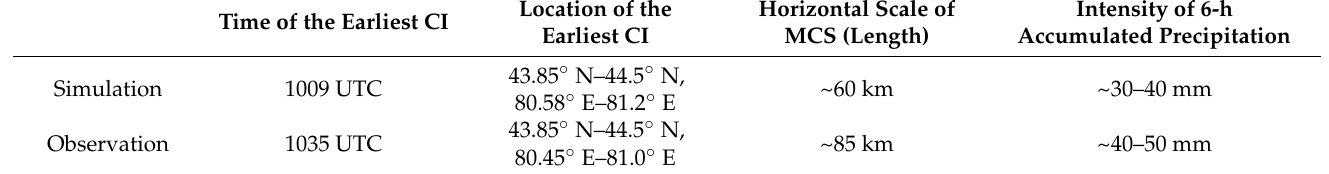
Table 1. The basic features of the CI, MCS and precipitation in simulation and observation.